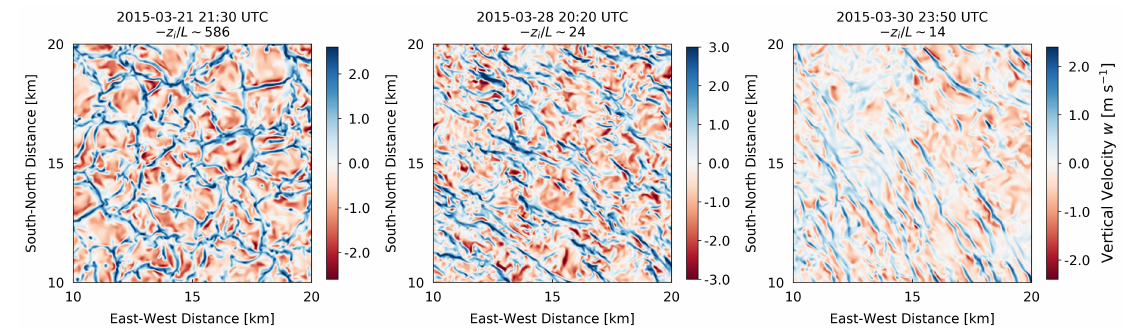
Figure 3. Instantaneous vertical velocity fields ( ∼ 100 m above ground) obtained from the innermost domain of the reference simulation RLES and shown for a box centered in the innermost domain and spanning 10 km × 10 km horizontally. These examples highlight differences in the turbulence structures depending on atmospheric stability: cell-dominated convection ( left ), transition ( center ) and roll ( right )